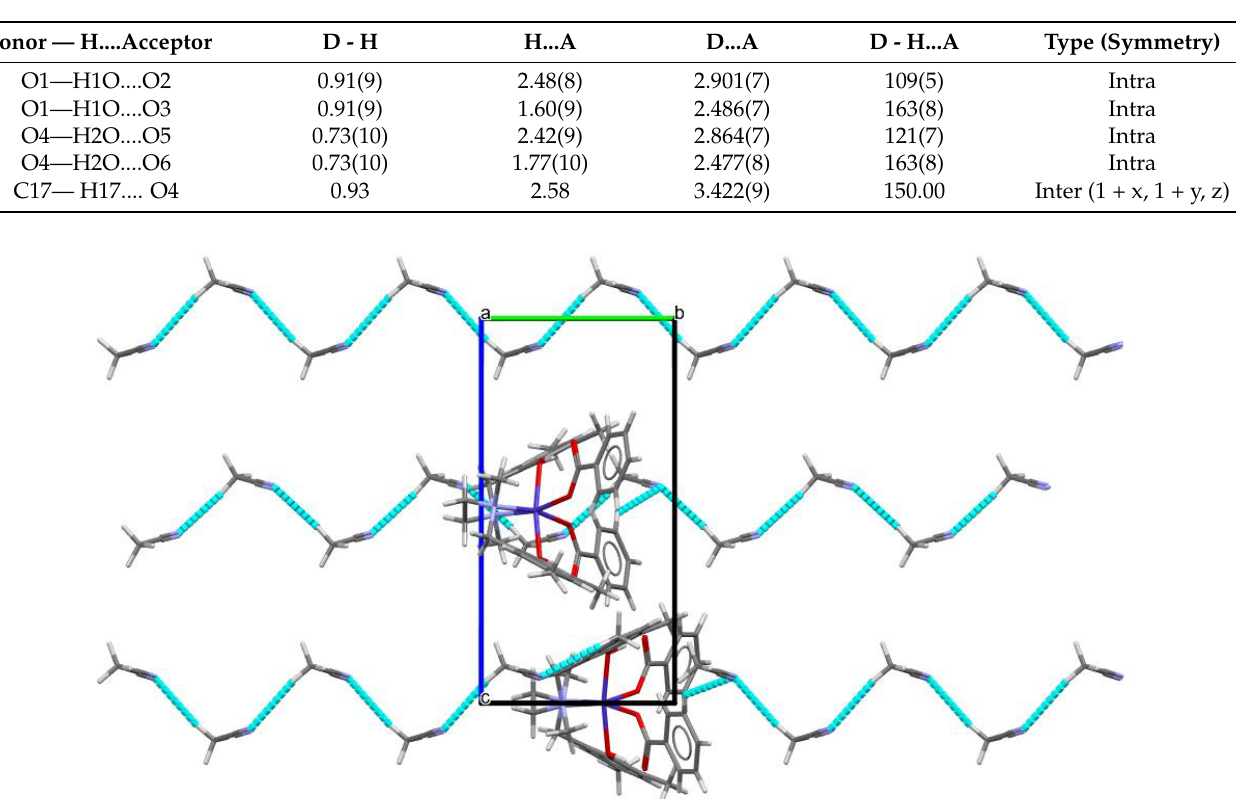
Table 1. Hydrogen-bonding geometries (Å and ◦ ) for 1 .